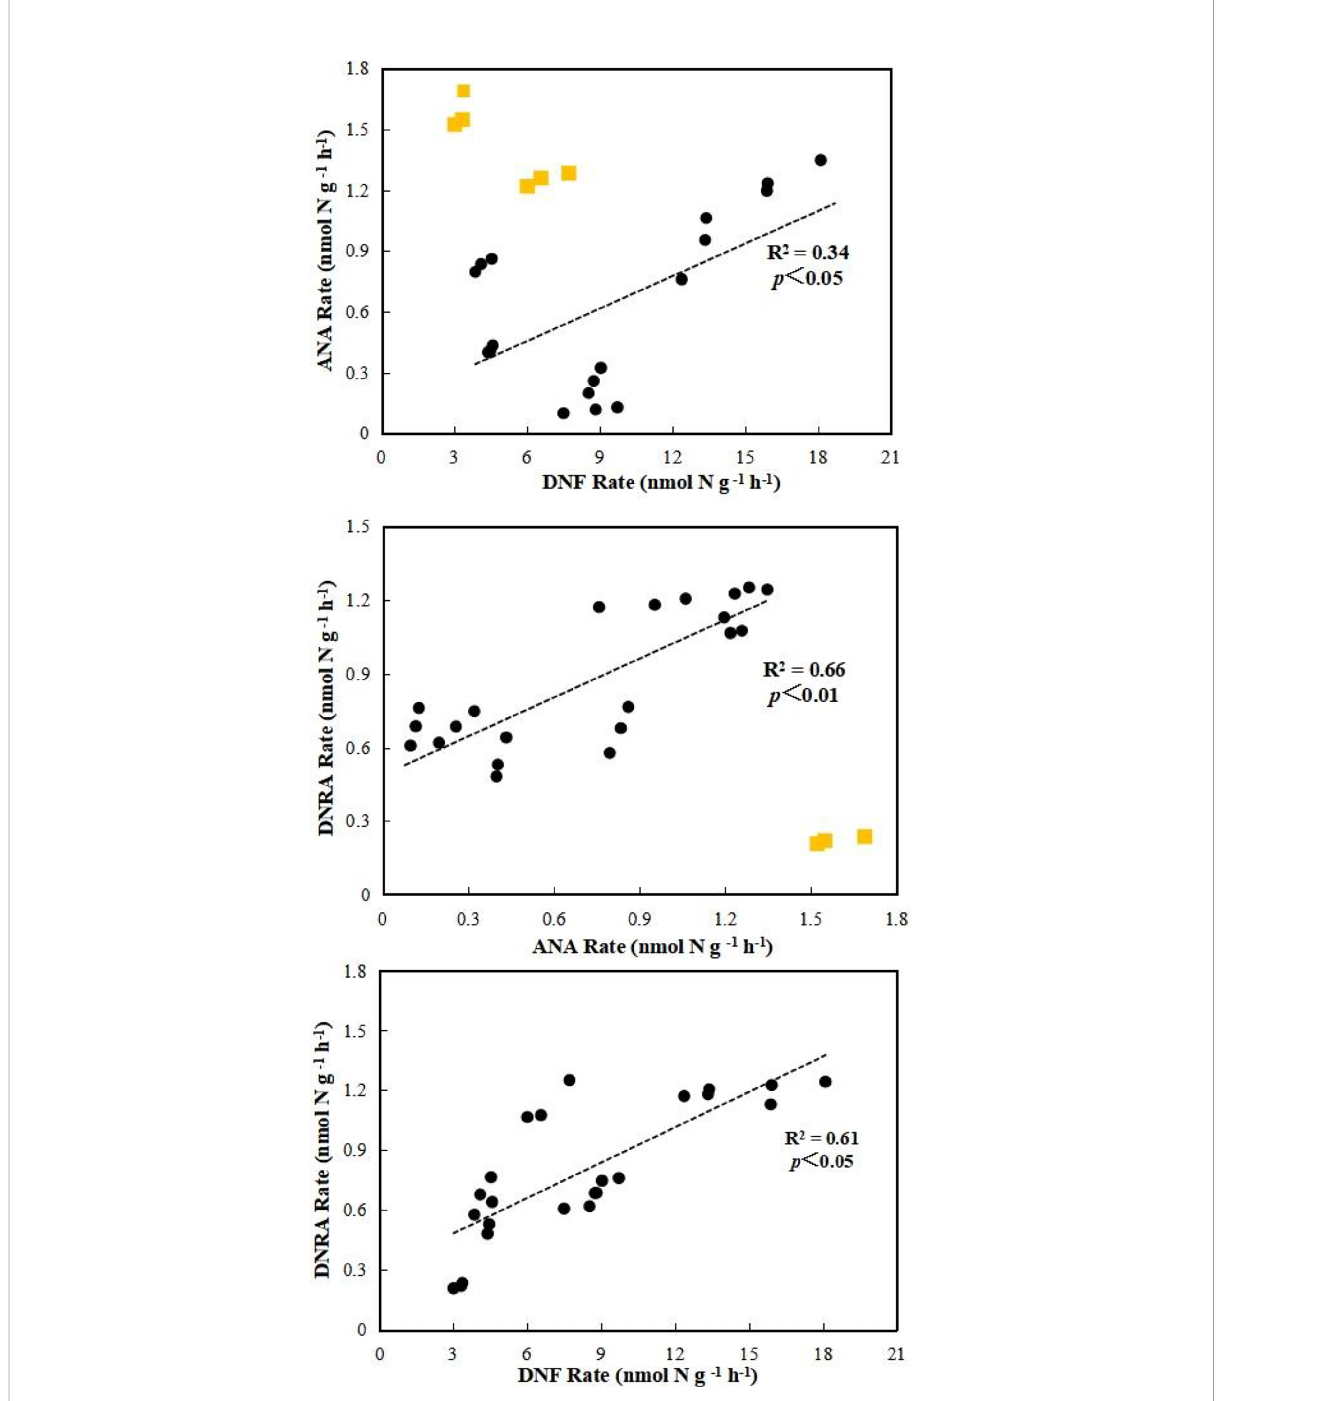
FIGURE 5 Correlations between DNF, ANA and DNRA rate. The linear regression is shown for the relation between DNF, ANA and DNRA rate. R 2 represents regression coef fi cient, and Yellow points represents not included in the statistics.The signi fi cance level was set at 0.05 and